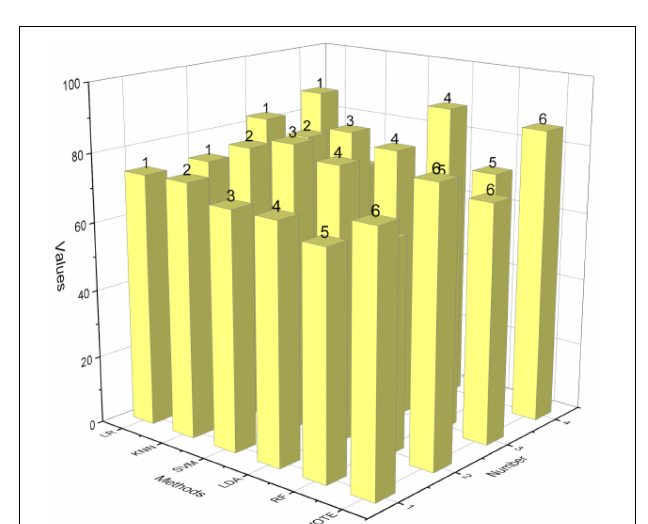
FIGURE 6 | Classification results.